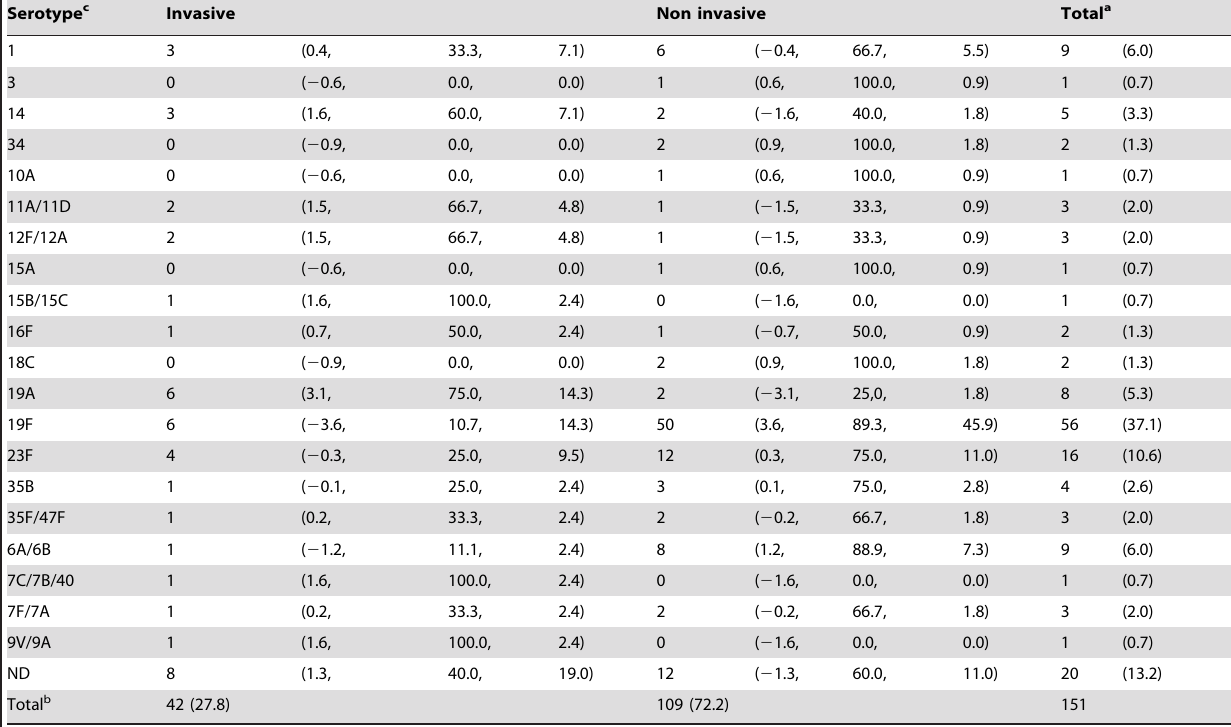
Frequency (adjusted residual, % within serotype, % within invasiveness) Serotype